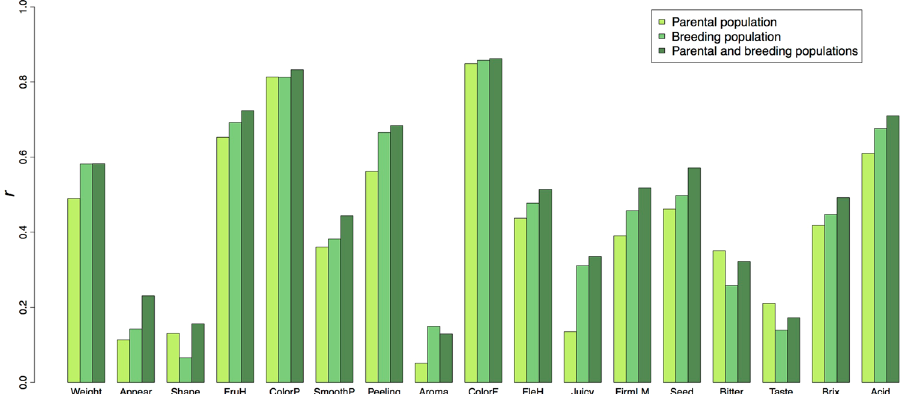
Figure 6. Prediction accuracy of the breeding population. Prediction accuracy was measured as the Pearson’s correlation coefficient ( r ) between predicted genotypic values and phenotypic values. The prediction accuracy was calculated for combined all families. Only the mean prediction accuracy of all the methods is shown (Supplementary Fig. S10). Training populations are shown in the figure key. When the breeding population or combined parental and breeding populations were used as training sets, one family was excluded and its phenotype was